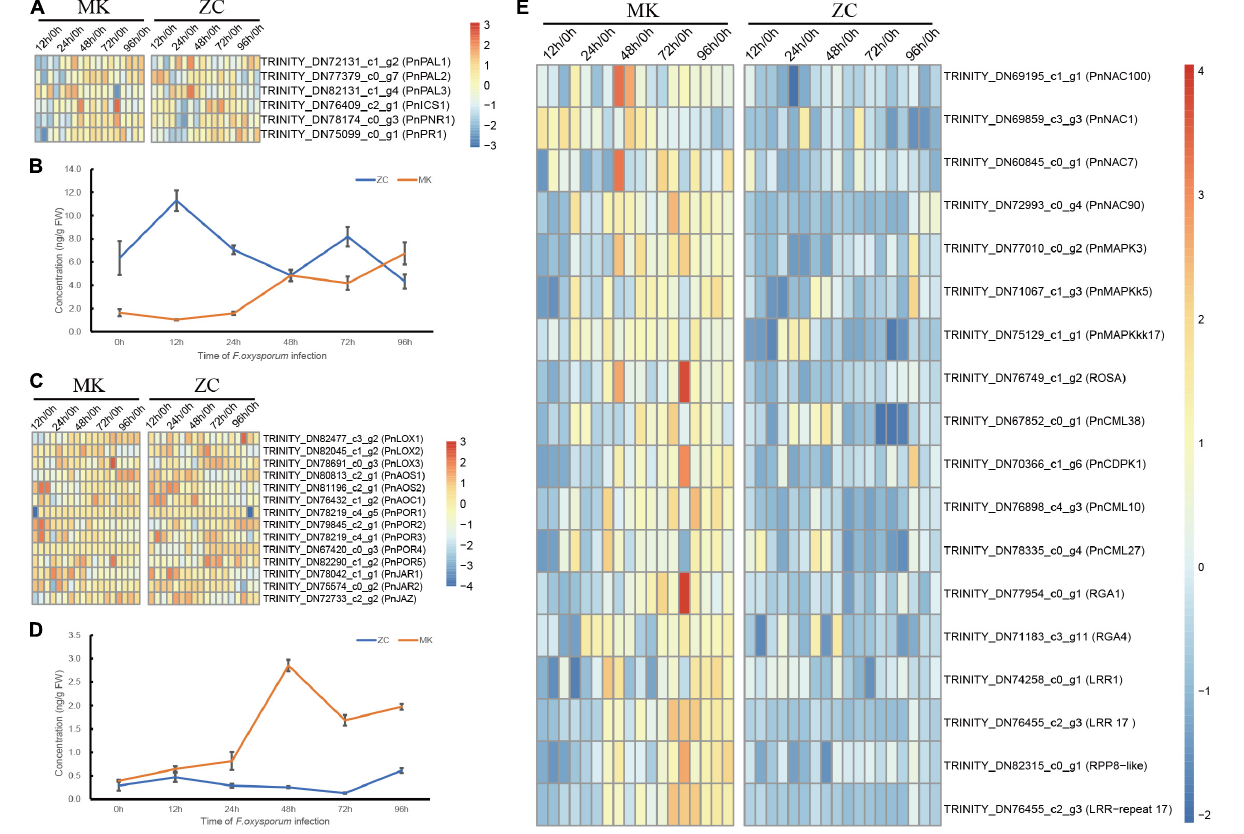
FIGURE 4 | Hormone levels and candidate genes expression during F. oxysporum infection in MK and ZC. (A,B) Effects of F. oxysporum infection on salicylic acid (SA), Heatmaps of SA biosynthesis and signal transduction-related gene expression (A) and concentrations of SA during infection (B) in MK and ZC. (C,D) Effects